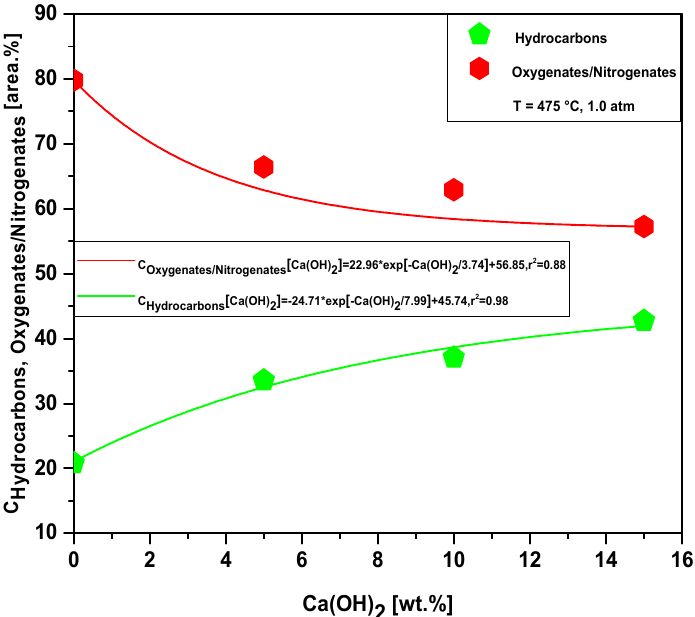
Figure 24. Effect of Ca(OH) 2 -to-MHSW ratio on the content of oxygenates and hydrocarbons in bio-oil obtained by catalytic cracking of MHSW fraction (organic matter + paper) at 475 °C, 1.0 atm, 5.0, 10.0, and 15.0% (wt.) Ca(OH) 2 , in laboratory scale.